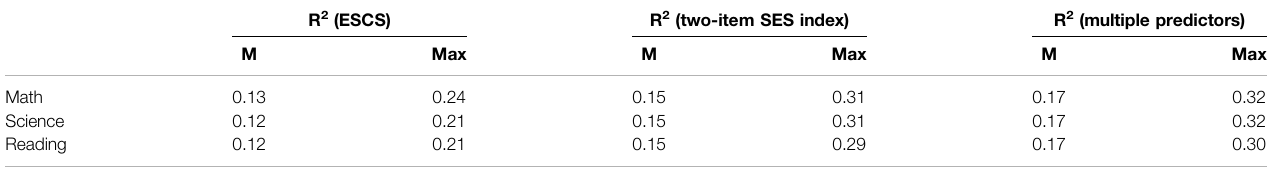
TABLE3| Theproportionofvariance(R 2 )inachievementexplainedbysocioeconomicstatuswhenSESisoperationalizedeitherbyPISA ’ scompositemeasure(ESCS),orby the new two-item index, or by multiple predictors.